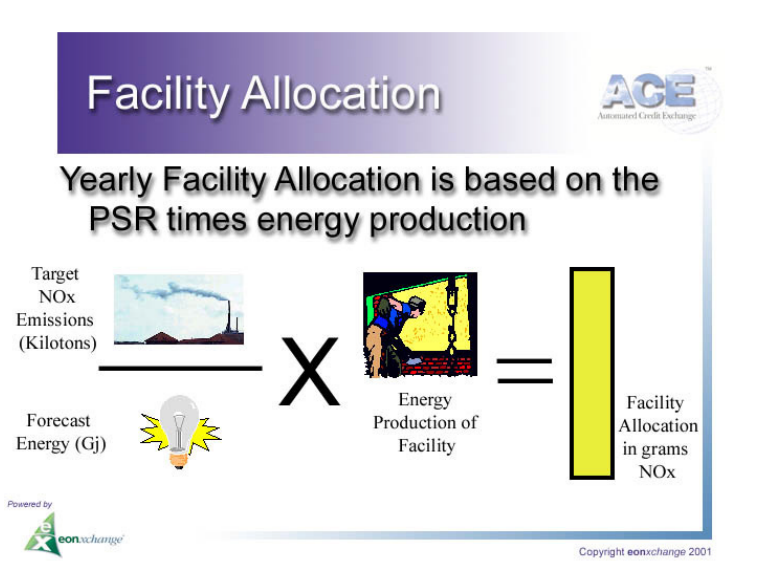
FIGURE 2. Facility